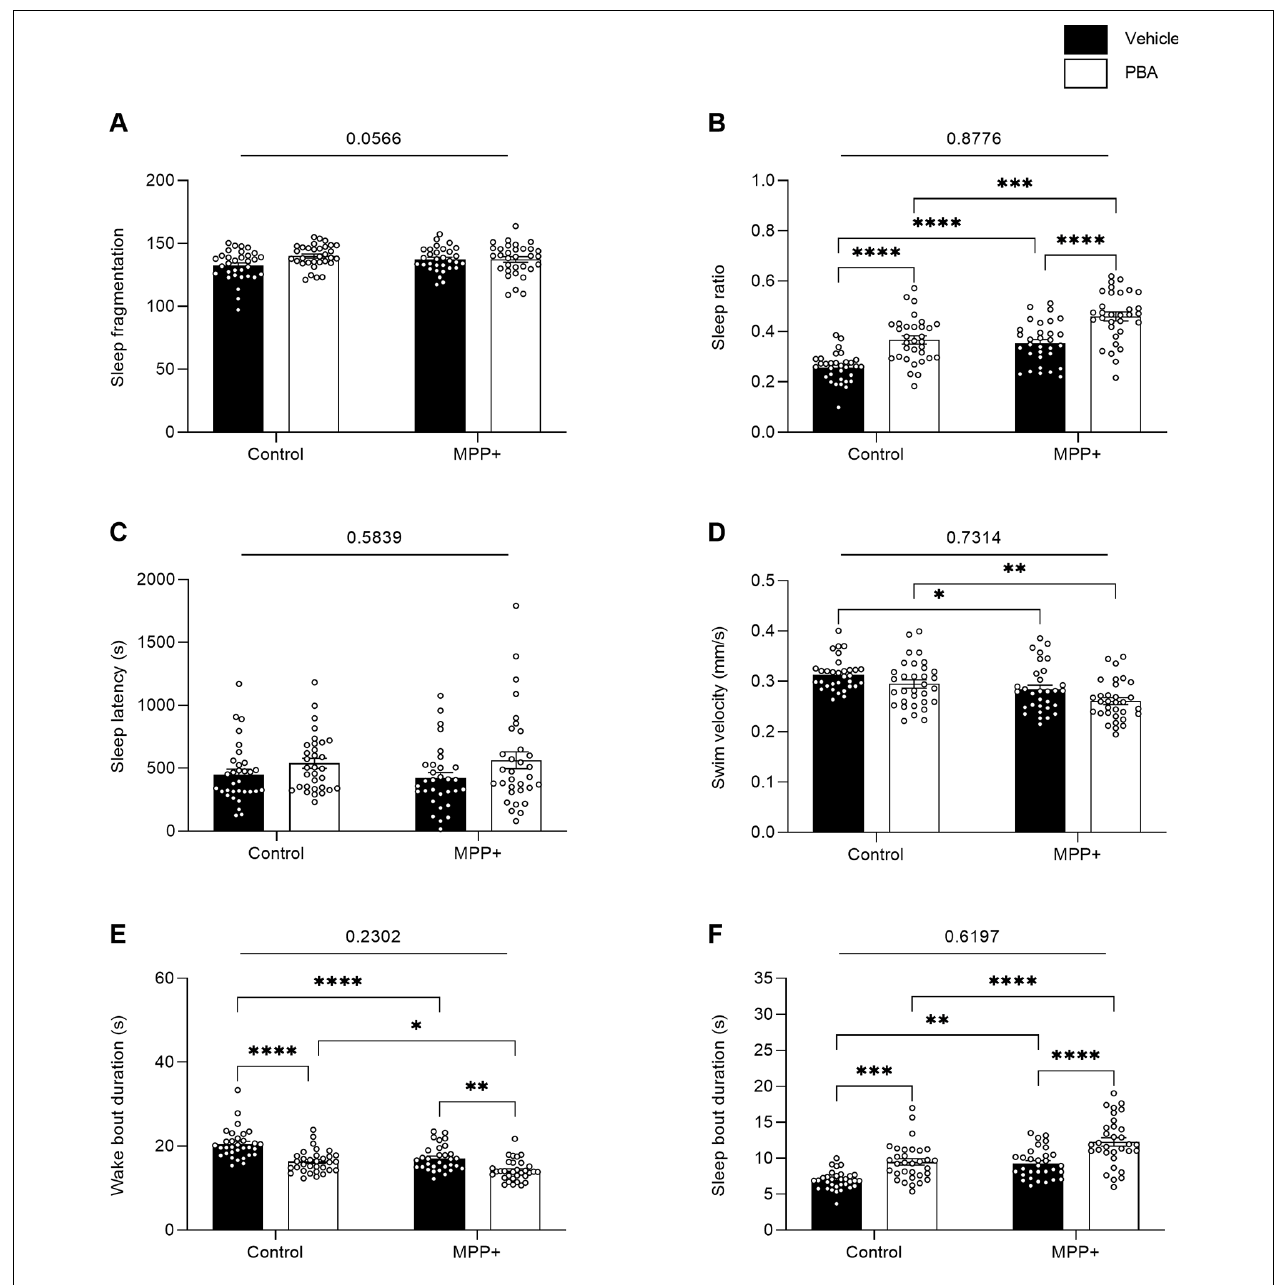
FIGURE 8 | Effects of PBA on the sleeping pattern of MPP+ treated zebrafish larvae. Larvae in the absence (Control) or presence of 500 µ M (MPP+) was treated with vehicle (black bars) or 100 µ M PBA (white bars). Sleeping pattern were evaluated for (A) sleep fragmentation; (B) sleep ratio; (C) sleep latency (s); (D) swim velocity (mm/s); (E) wake bout duration (s) and (F) sleep bout duration (s). Data are represented as means ± SEM from a single experiment, control group n = 32, MPP+ group n = 31, PBA group n = 32, MPP+/PBA group n = 32. Normality was tested using D’Agostino and Pearson omnibus normality test followed by